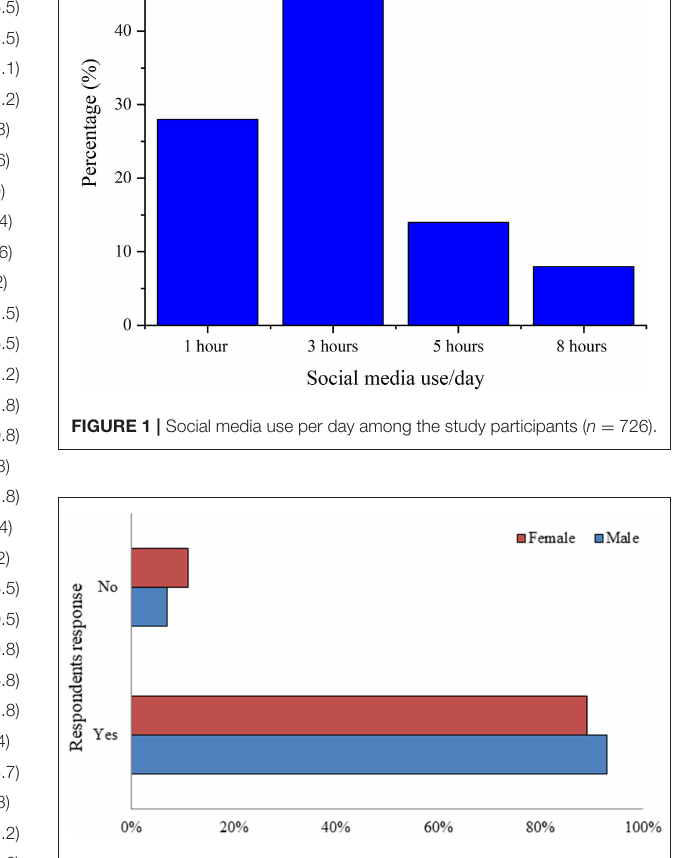
TABLE 1 | Demographic characteristics of the study participants ( n = 800). Characteristics